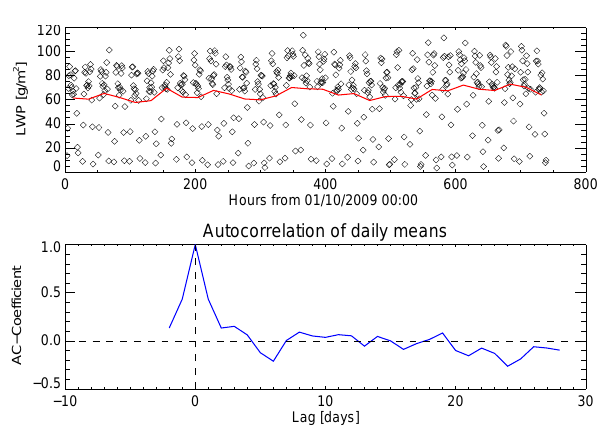
Fig. 4. Upper panel: time series of LWP for low clouds in Europe, 10/2009, diamonds depict spatial averages for Europe of the indi- vidual time slots, i.e. one diamond per hour; the red line shows the daily averages of the respective data points; lower panel: auto- correlation function of daily averaged